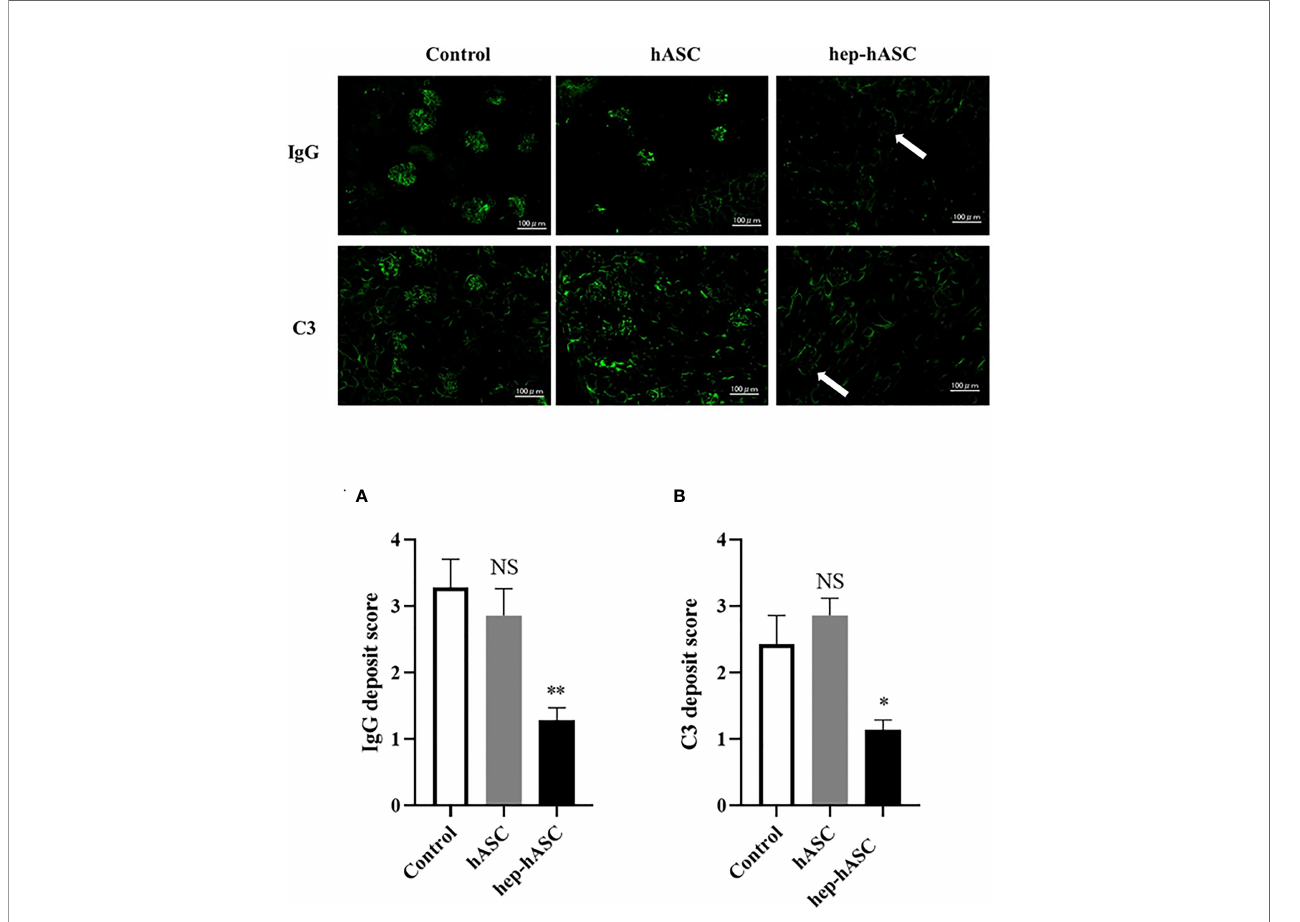
FIGURE 4 | Effect of hep-hASC transplantation on IgG and C3 deposition in the kidneys of NZB/W F1 mice. Representative images showing renal IgG and C3 deposition in NZB/W F1 mice at age 26 weeks. Glomerular IgG (A) and C3 (B) deposition were graded as described in Material and Methods . Data expressed as mean ± SEM (N=7 mice per group). *P < 0.05. **P < 0.01. NS, not signi fi cant vs. control group. Original magni fi cation